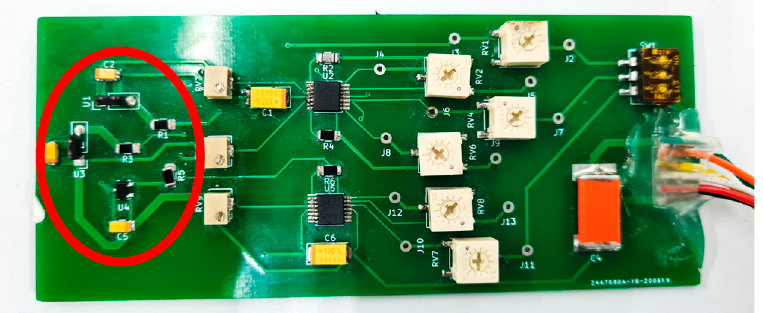
Figure 2. This board allows capturing signals from the three orthogonal magnetic stray flux components.